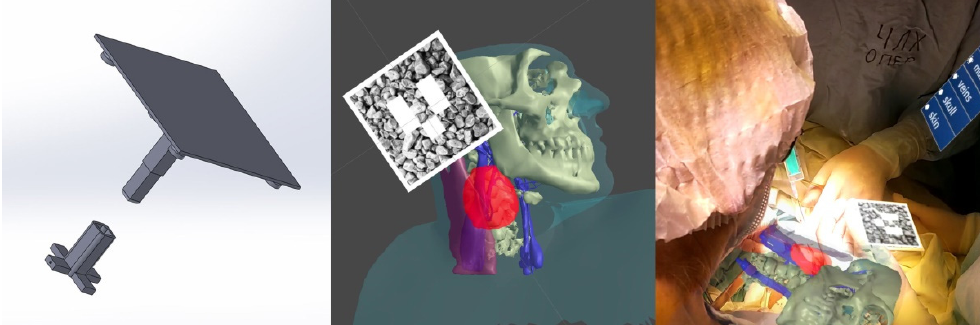
Figure 10. Construction of 3D model of anatomical structures using 3D Slicer. Standardization of the patient’s position in the operating room and intraoperative image in mixed reality glasses (Microsoft HoloLens 2).